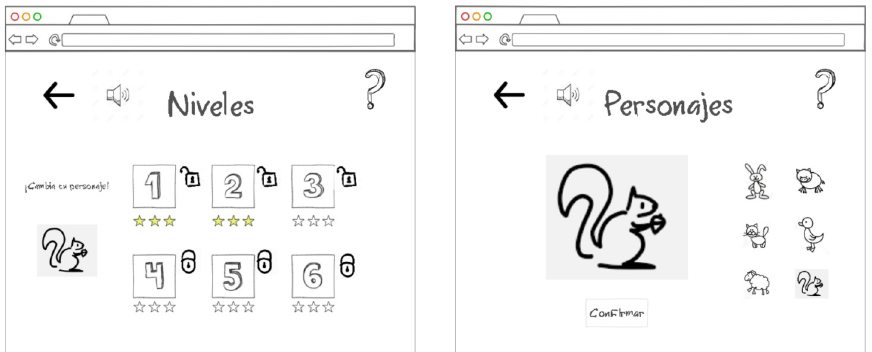
Fig. 6. Interface prototype to select the level and character to play a game